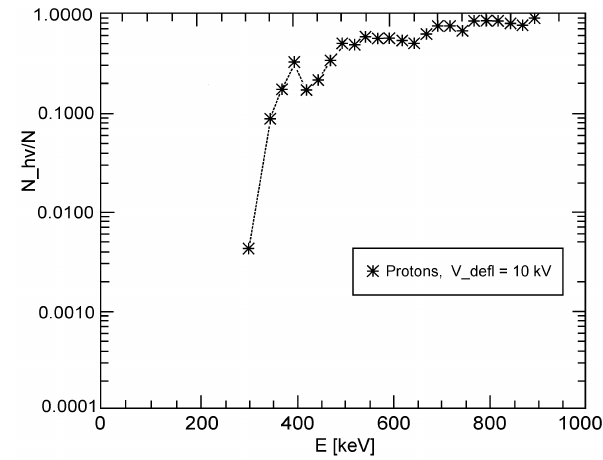
Fig. 5. Part of the HV deflection/collimation system which consists of circular plates and supporting PEEK insulators/spokes (the top plate is removed).